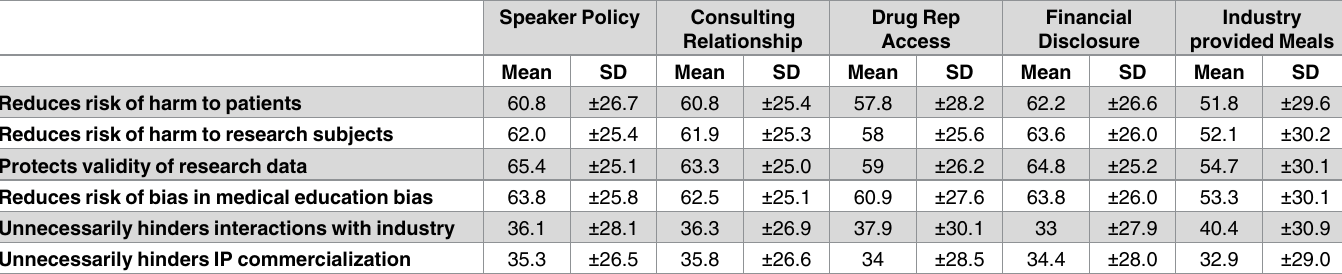
Table 5. Respondent perceptions of impact of selected COI policies